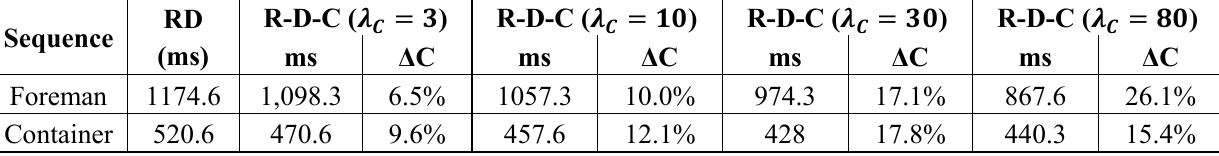
Table 1. Average decoding